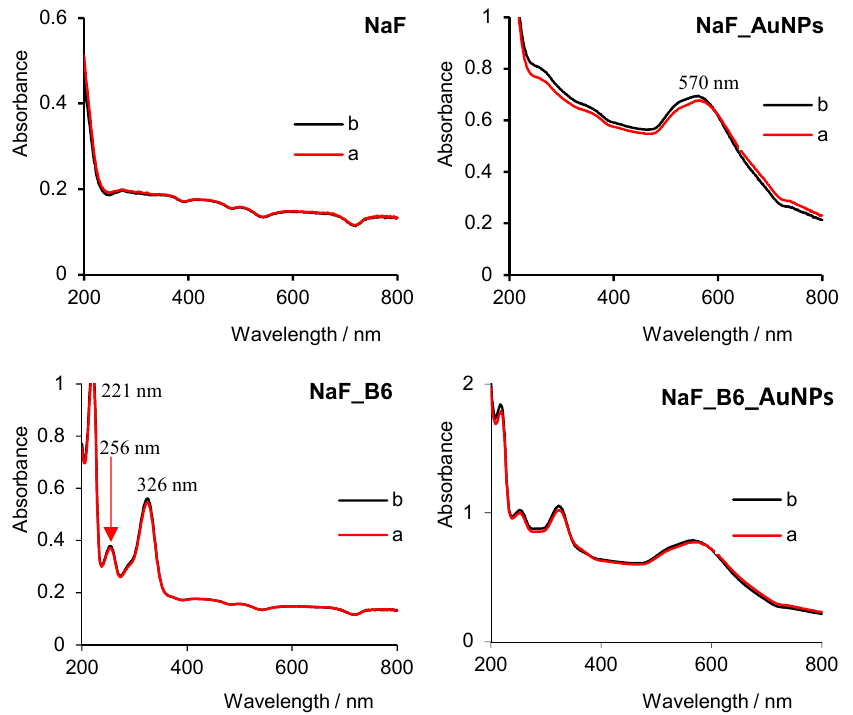
Figure 2. UV–Vis absorption spectra of electrolyte solution containing NaF/B 6 /AuNP systems; b—before and a—after performing cyclic voltammetry.